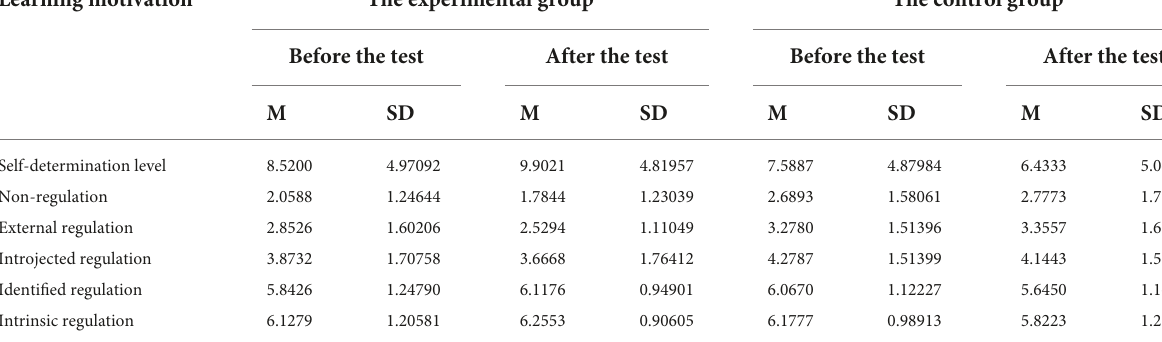
TABLE 2 Motivation levels of the experimental group and the control group before and after